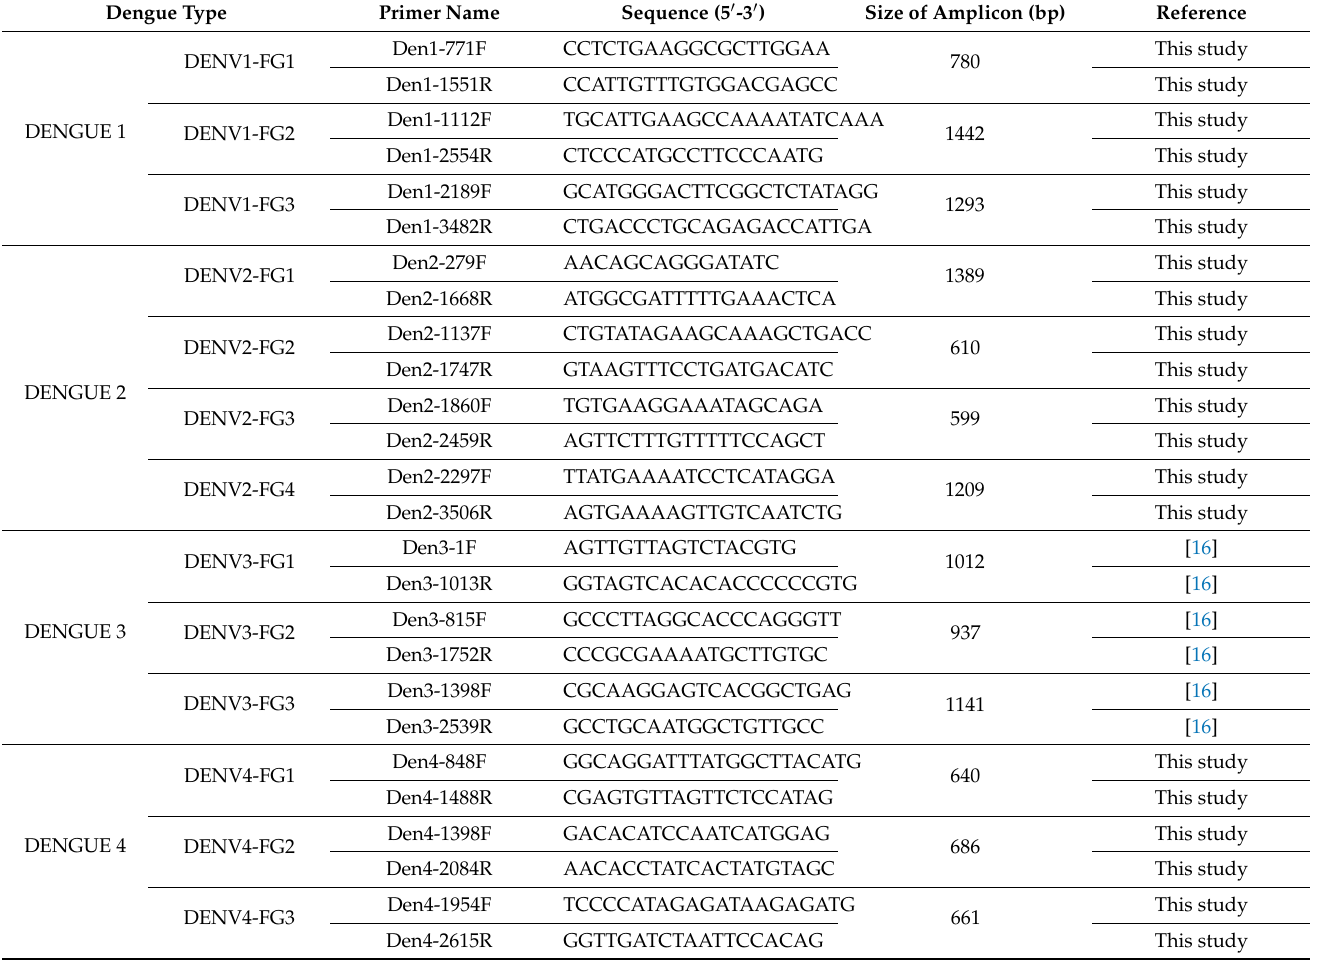
Table 1. Primers used for the sequencing of envelope gene